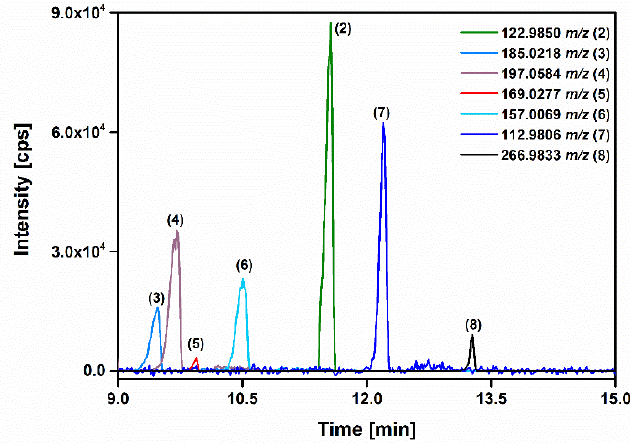
Figure 5. Electropherogram of the organophosphates (OPs) in the aged electrolyte sample containing dimethyl phosphate (DMP) and 1,3 ‐ propane sultone (PS).